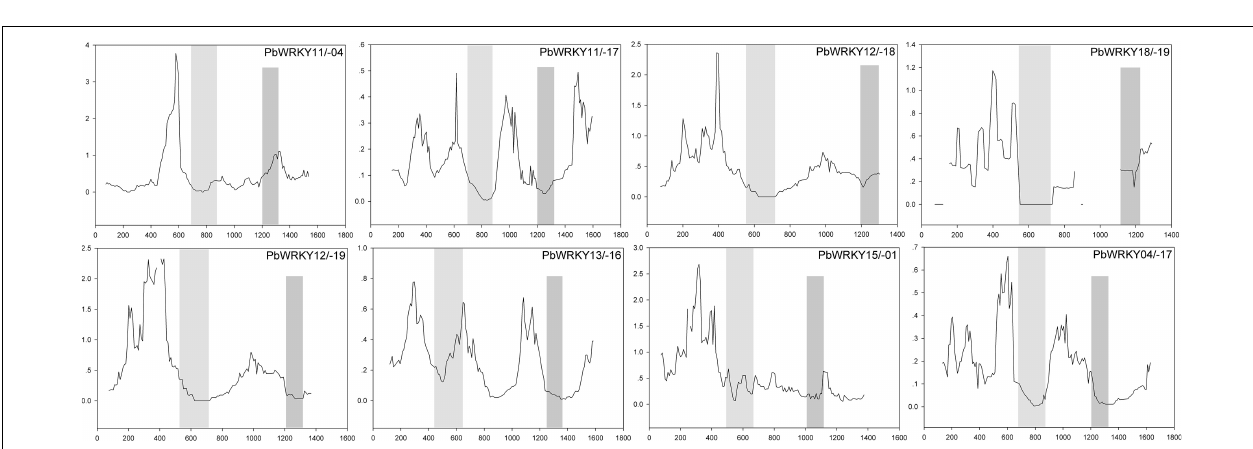
FIGURE 5 | Estimates of Ks and Ka/Ks ratios of duplicated WRKY I genes in P. bretschneideri (A) and M. domestica (B) . The x- and y-axes denote the synonymous distance and Ka/Ks ratio for each pair, respectively. Ka, non-synonymous; Ks, synonymous.